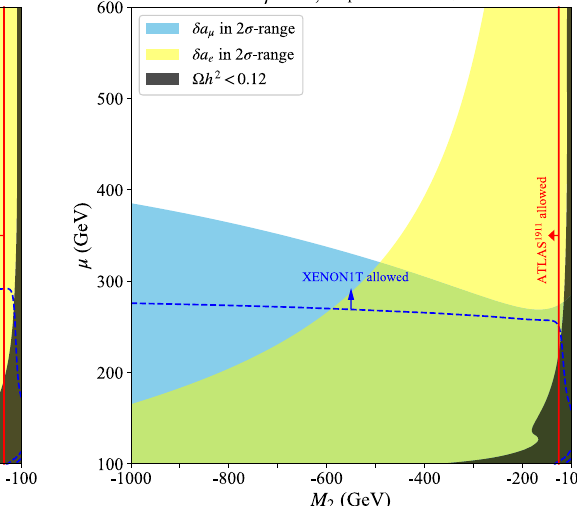
explaining the muon and electron g − 2 anomalies are also shown. For the curves of limits, the regions indicated by the arrows are the allowed regions